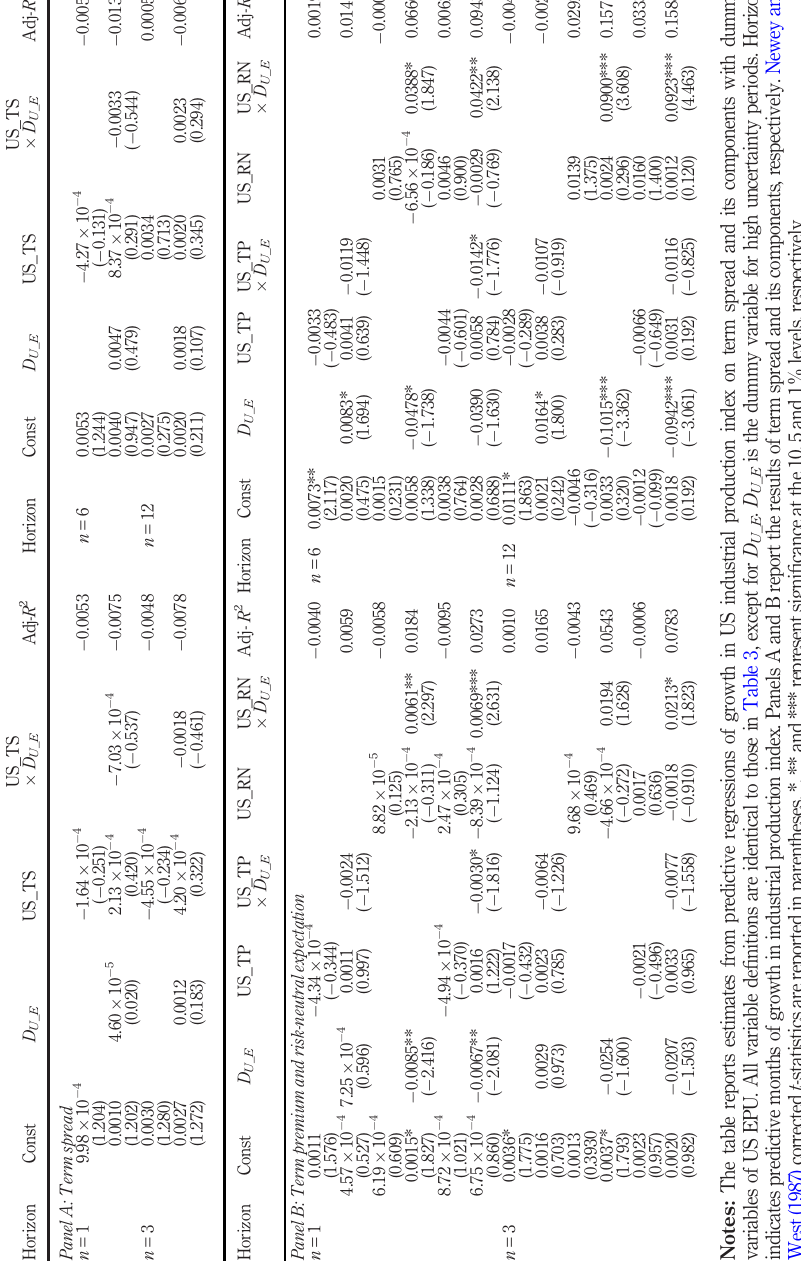
Table 8. Information of term spread and its components with uncertainty in US economy: